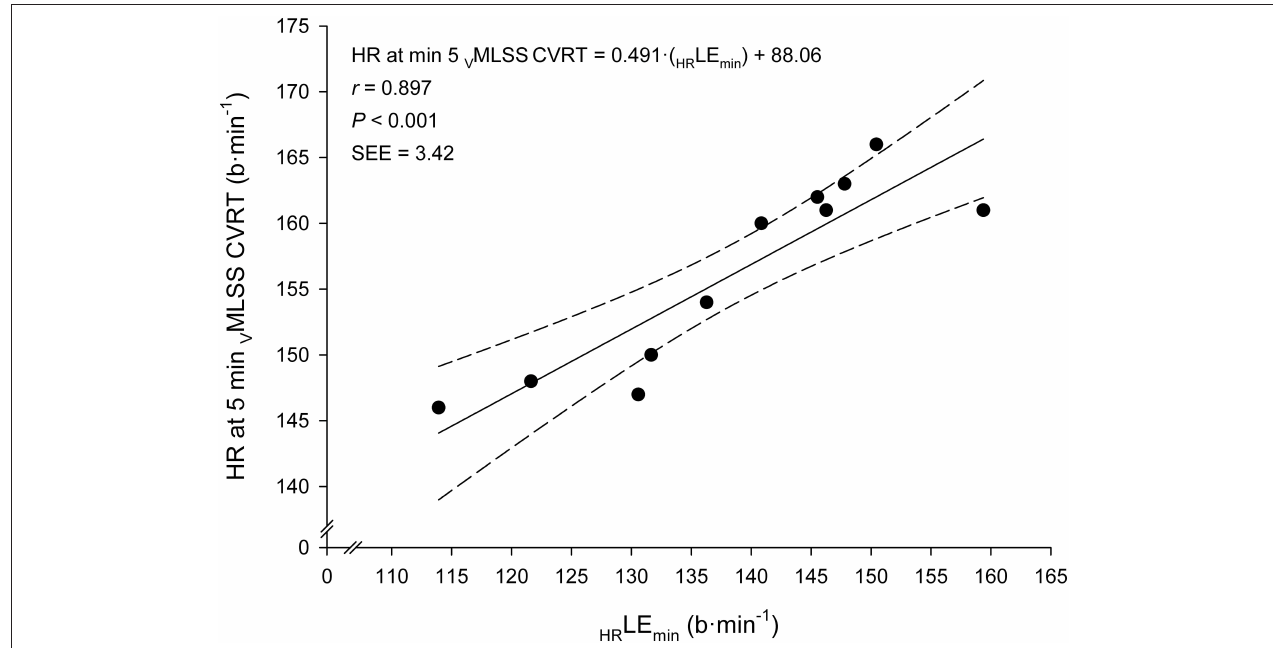
FIGURE 6 | Linear regression between heart rate (HR) at the Lactate Minimum Equivalent ( HR LE min ) and HR at min 5 of the constant velocity running test (CVRT) performed at the velocity of the maximal lactate steady state ( V MLSS).